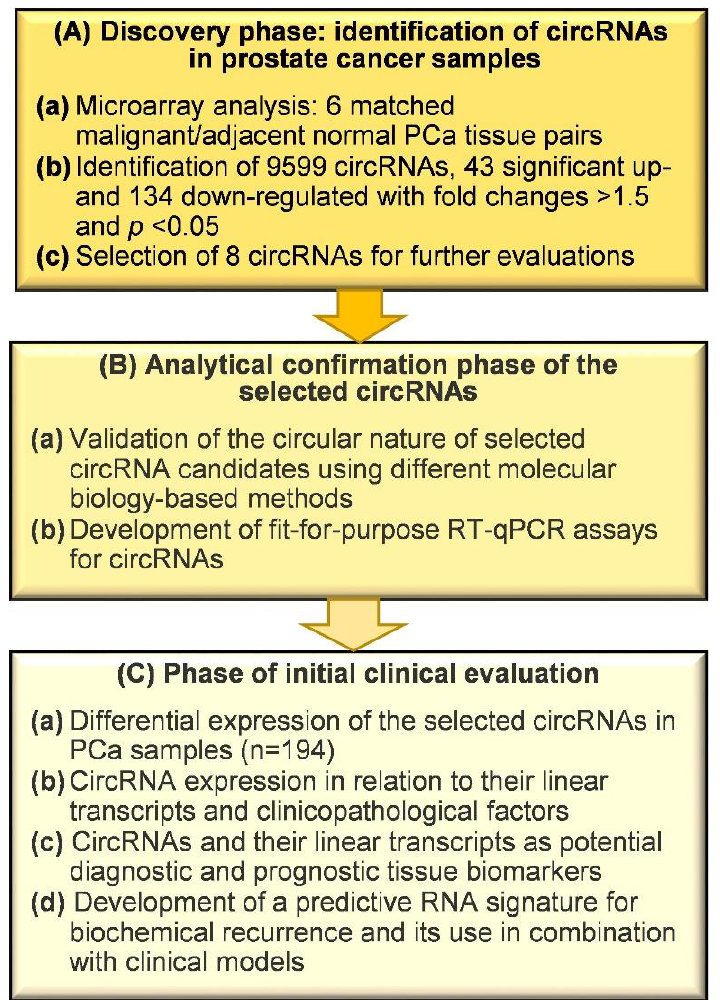
Figure 1. Workflow of the study in three phases. Abbreviations: circRNA, circular RNA; PCa, prostate cancer; RT-qPCR, reverse-transcription quantitative real-time polymerase chain